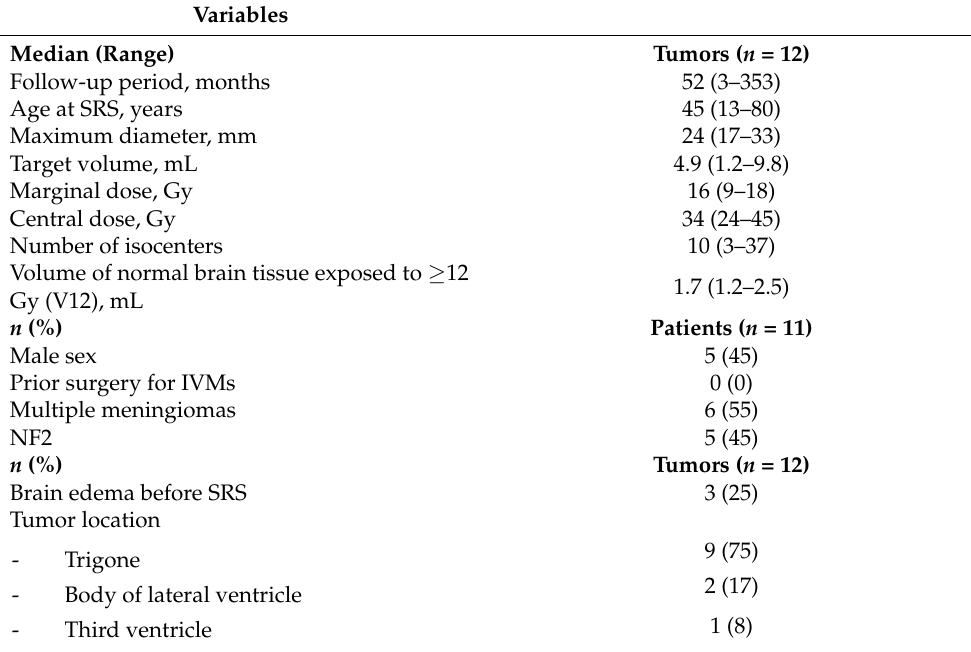
Table 1. Patients’ baseline characteristics and treatment data of stereotactic